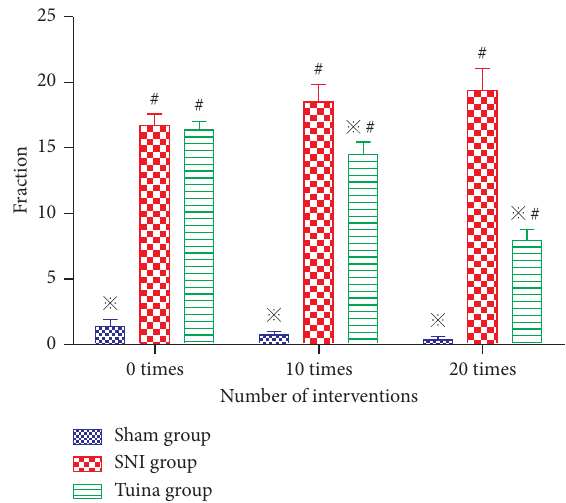
Figure 1: Comparisons of cumulative pain scores of rats in each group. ※ Compared with the SNI group, P < 0 . 05; # compared with the Sham group, P < 0 . 05.